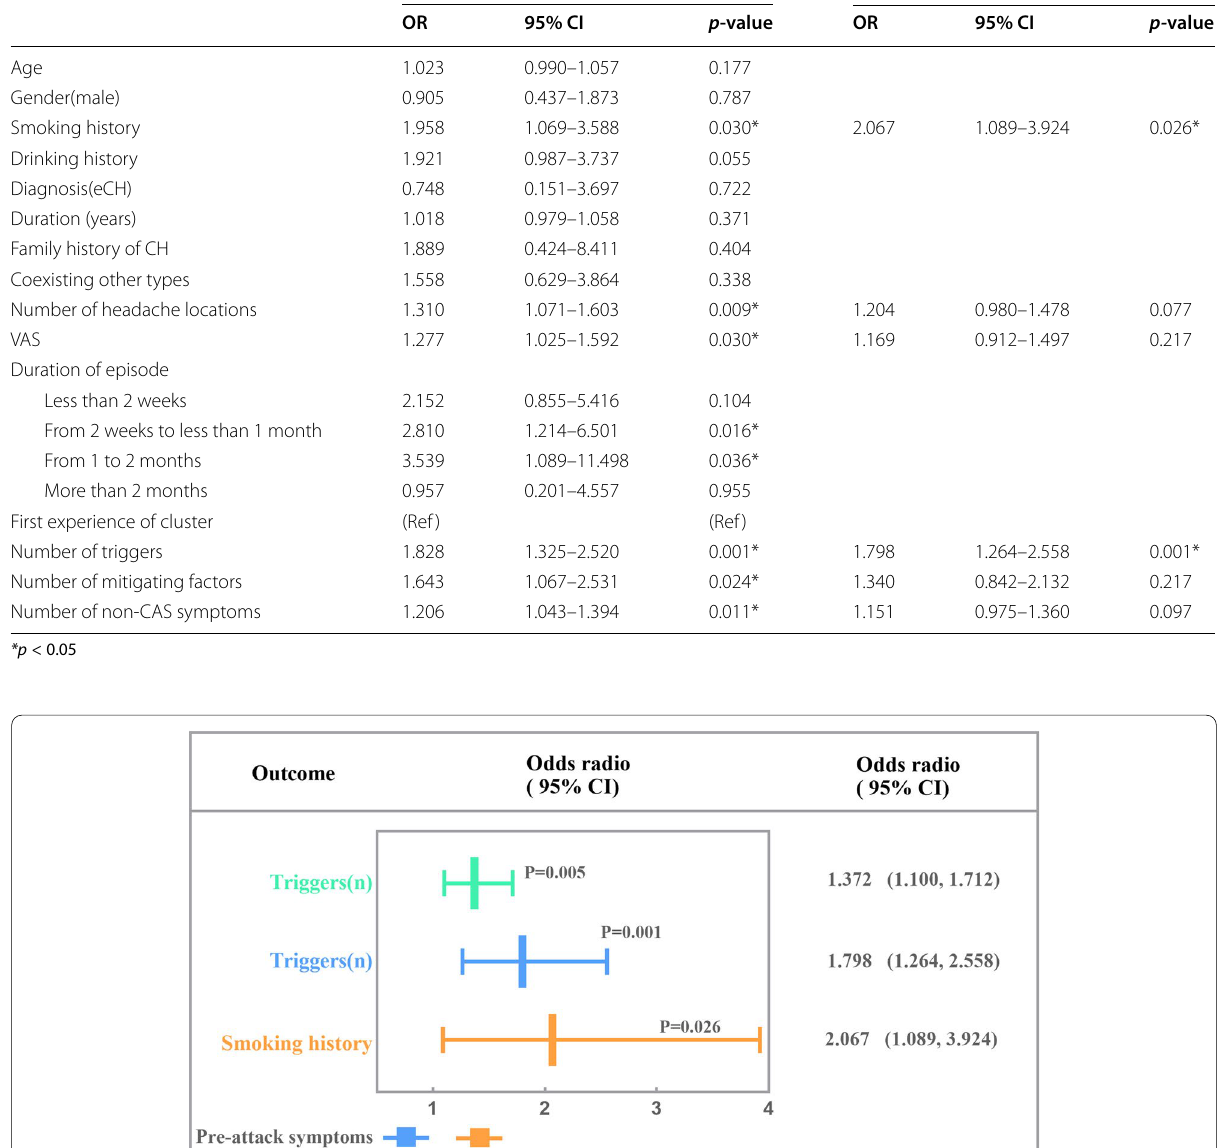
Table 2 Univariable and multivariable logistic regression analyses to assess factors associated with PAS